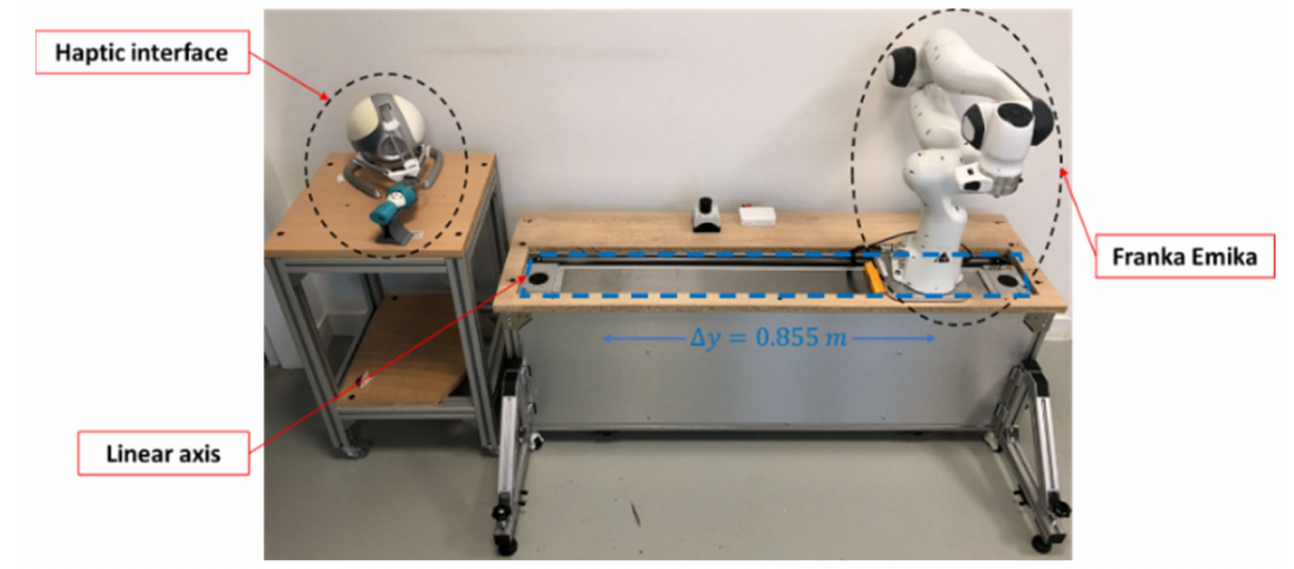
Figure 3. Assembled prototype of the 8-DoF robotic platform for medical